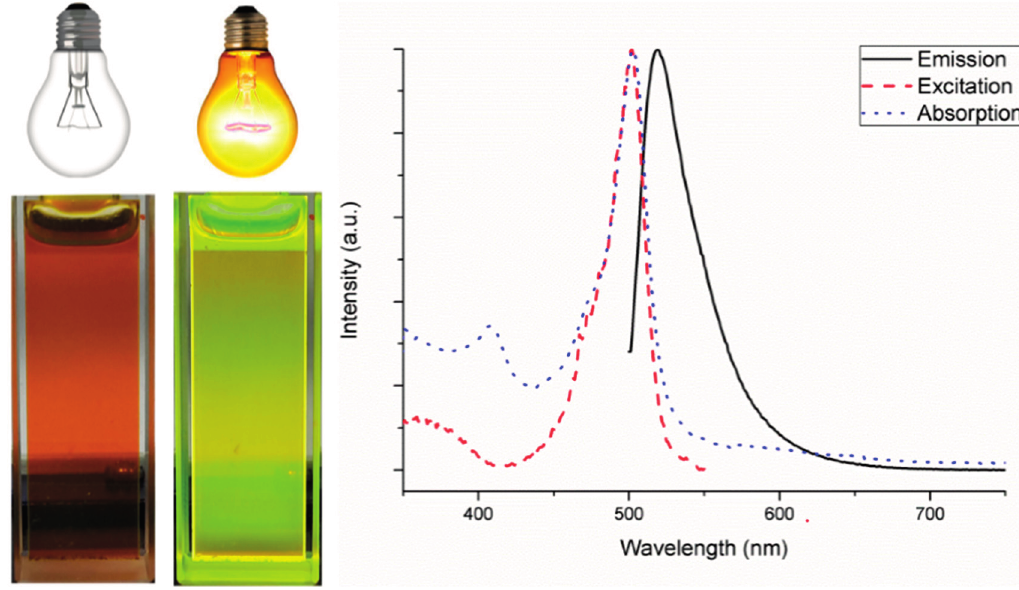
Figure 4. The emission (black line), excitation (red dashed line) and absorption (blue dotted line) spectrum of Gd-DOTA-BODIPY in